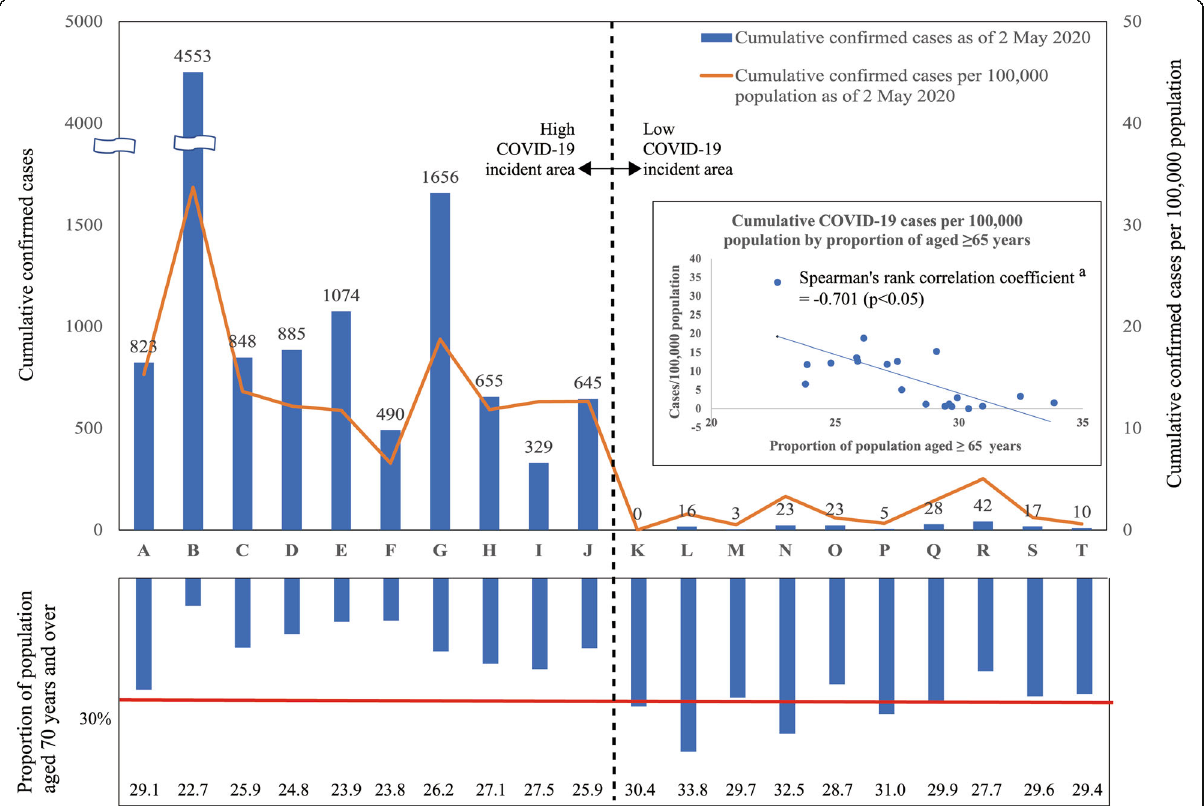
Fig. 1 Cumulative COVID-19 cases, cases per 100,000 population and proportion of population aged ≥ 65 years. a Due to non-normal distribution of data, Spearman ’ s rank correlation test was adopted. Cumulative COVID-19 cases and cases per 100,000 population are calculated based